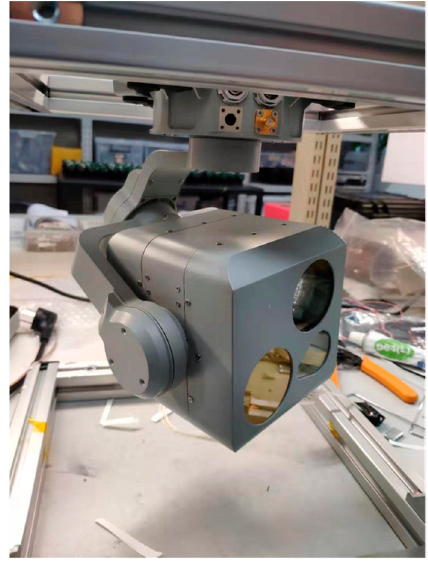
Figure 3. Experimental platform.